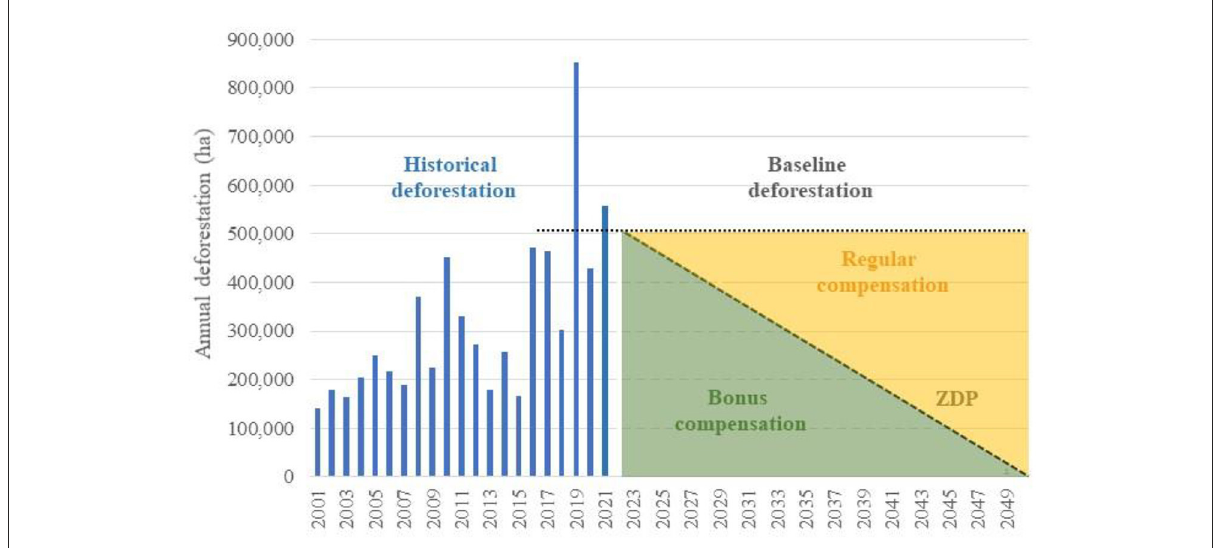
FIGURE5 Historical deforestation, NDC commitment, and Zero deforestation by 2050 (Scenario 1). Source: Authors’